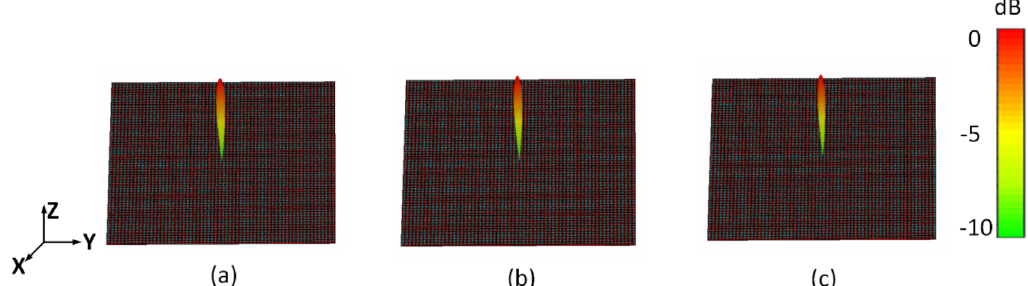
Fig. 9. Normalized E-pattern of Metasurface II at (a) 1.30 THz, (b) 1.50 THz, (c) 1.70 THz when the chemical potential is